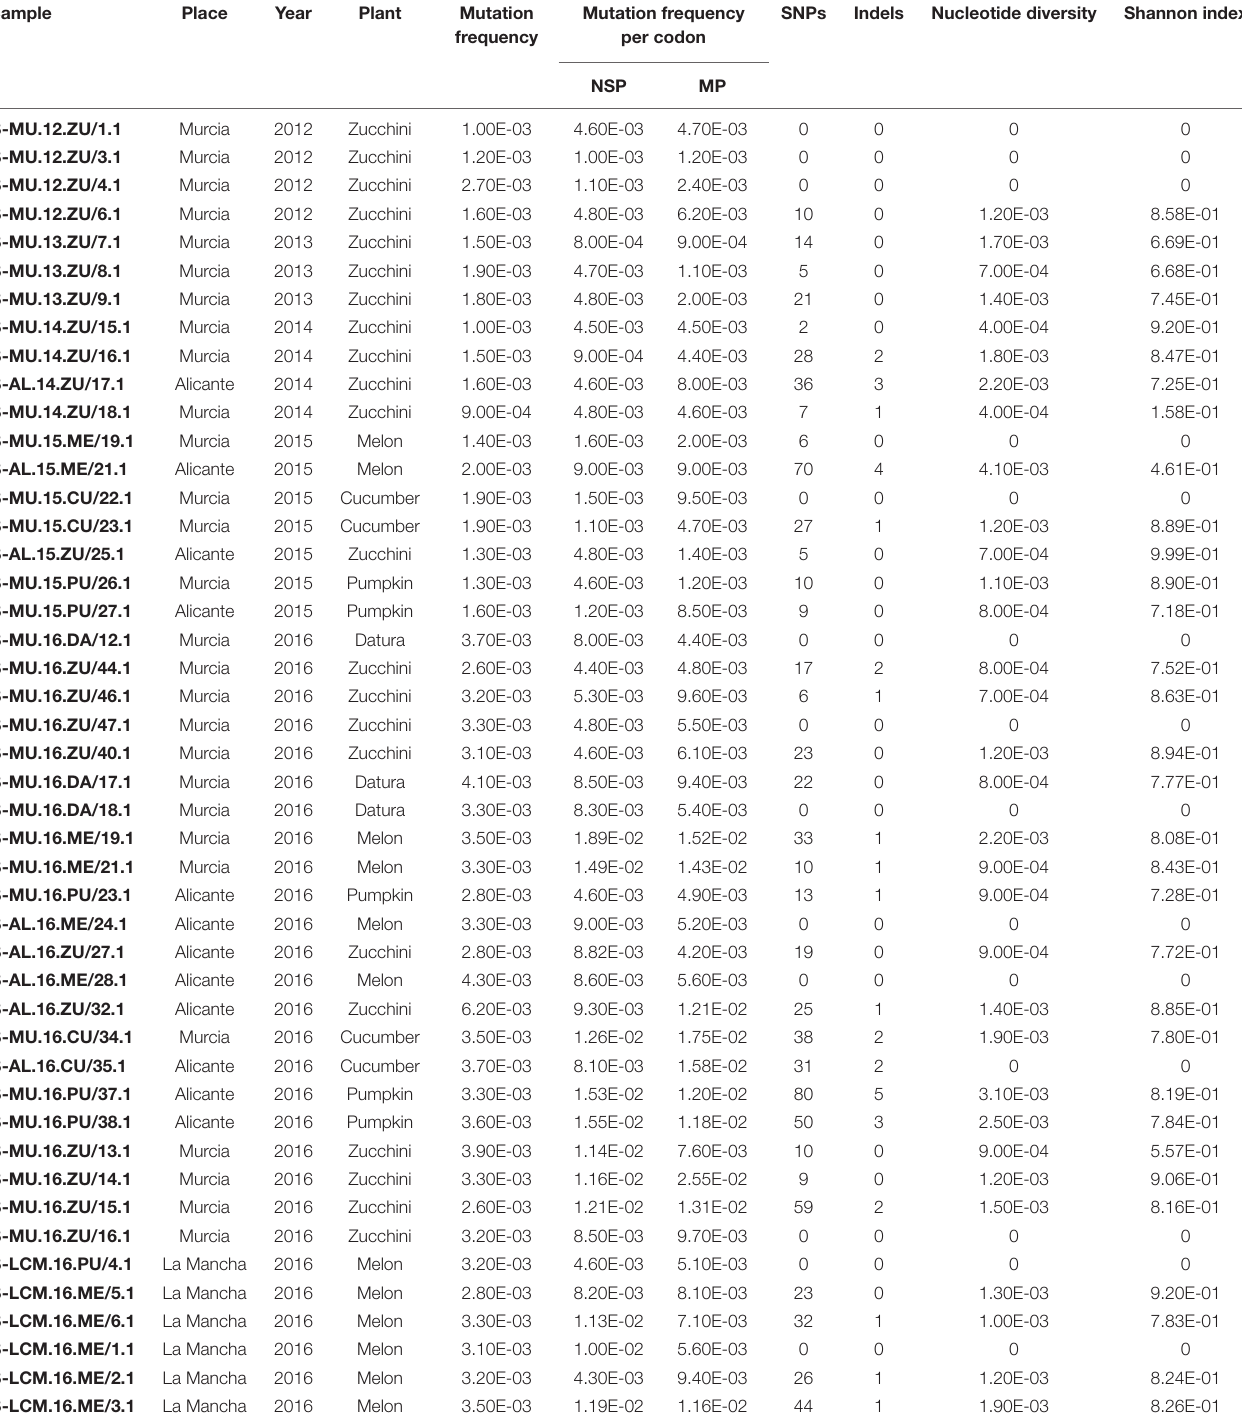
TABLE 3 | Estimation of the within-population genetic parameters for genome B of the ToLCNDV isolates. Samples are listed by fitting the location, year and host, and values show the mutation frequency (mutations/nucleotide position) for each genome, while mutation frequency for each gene was estimated by mutation frequency per codon. Numbers of SNPs, indels, nucleotide diversity and Shannon index were estimated by retracting the 10 − 3 error rate correction. Sample